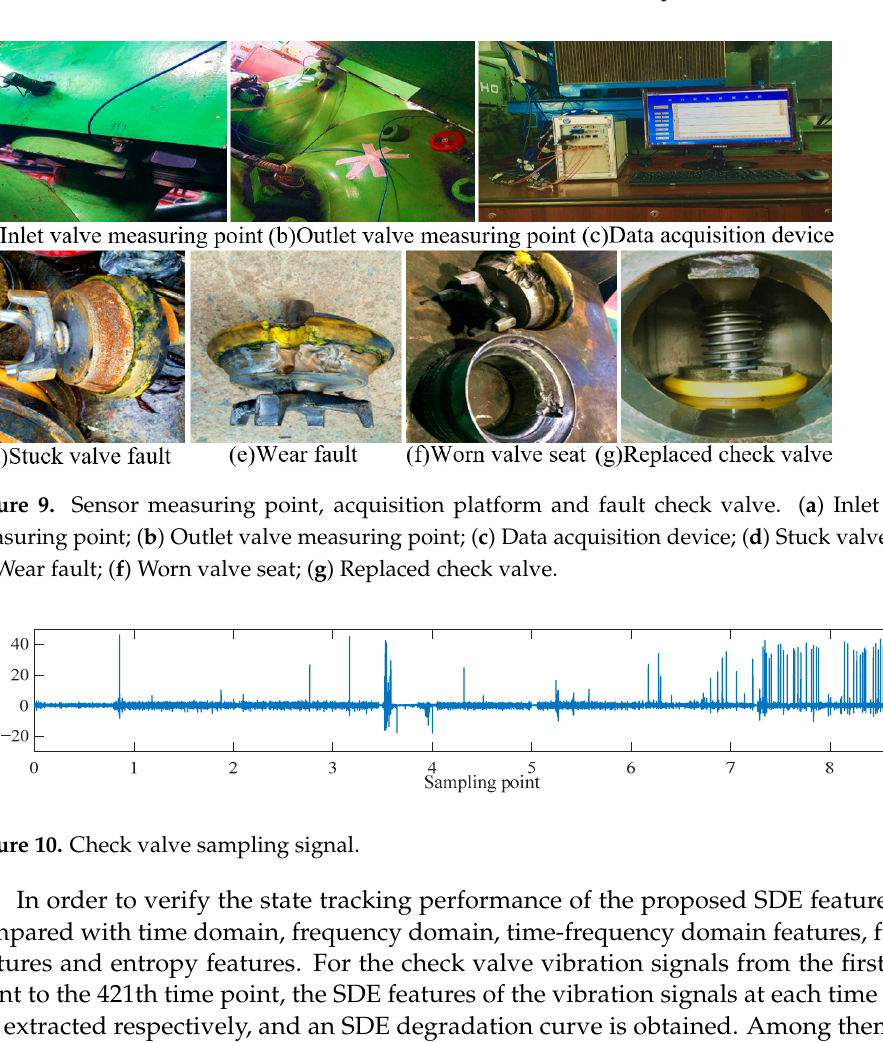
Figure 10. Check valve sampling signal.